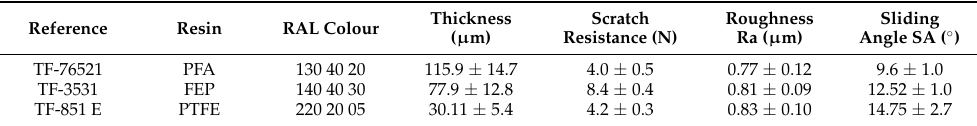
Table 1. Characteristics of the PFA, FEP, and PTFE fluoropolymeric coatings used.